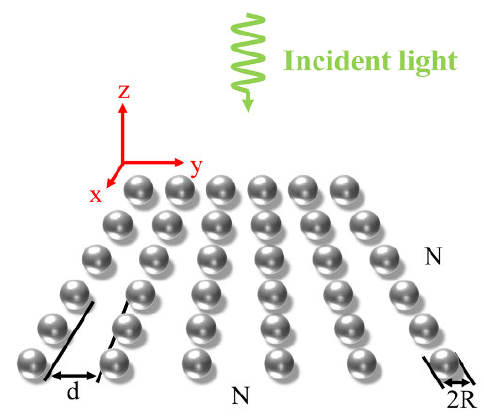
Figure 1. Schematic diagram of square array of spherical nanoparticles.